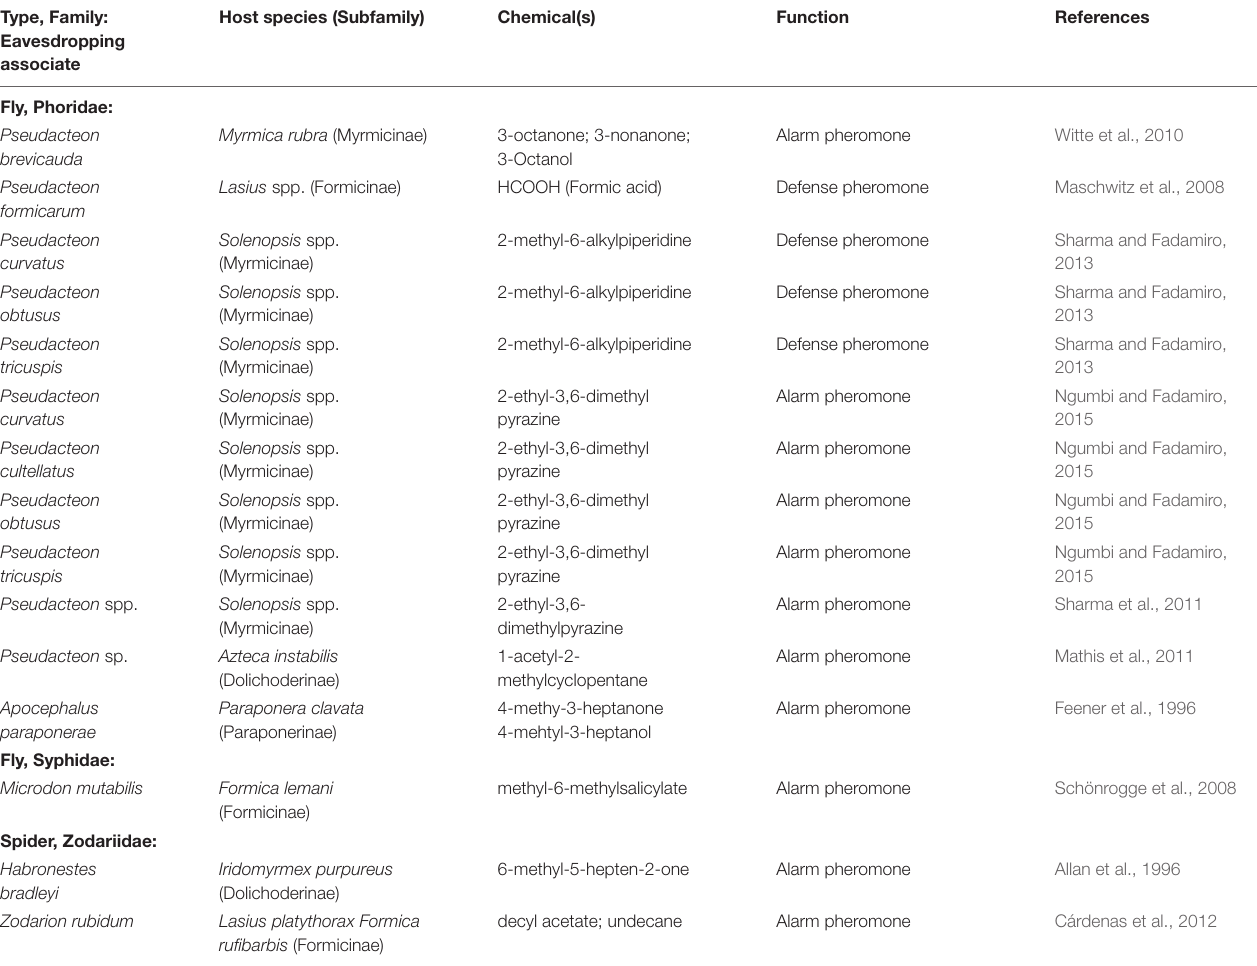
TABLE 3 | Experimentally determined chemicals used by eavesdropping ant